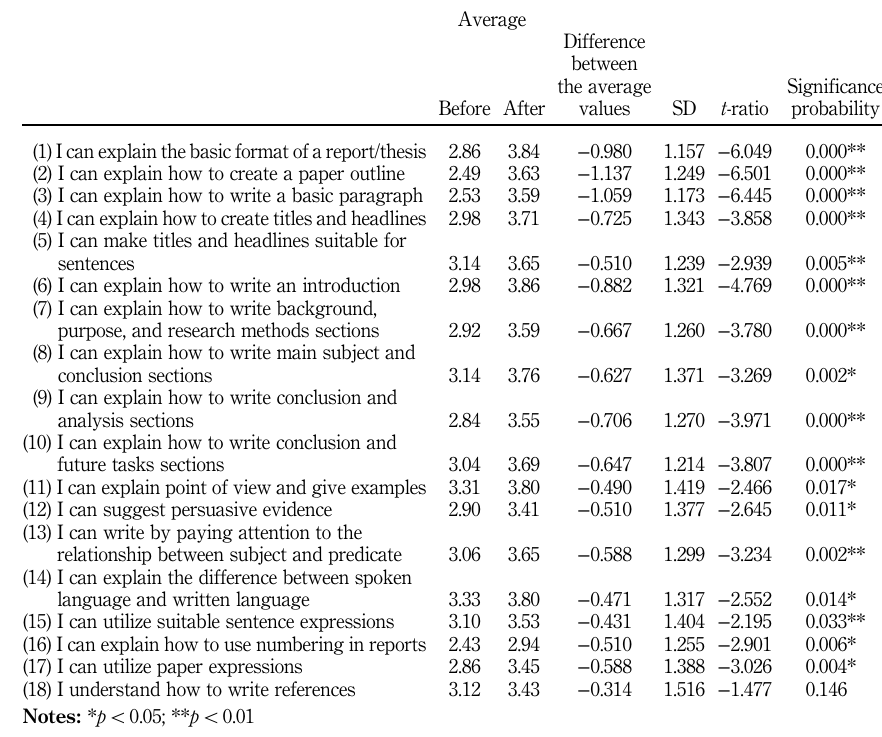
Table II. Results of e-learning